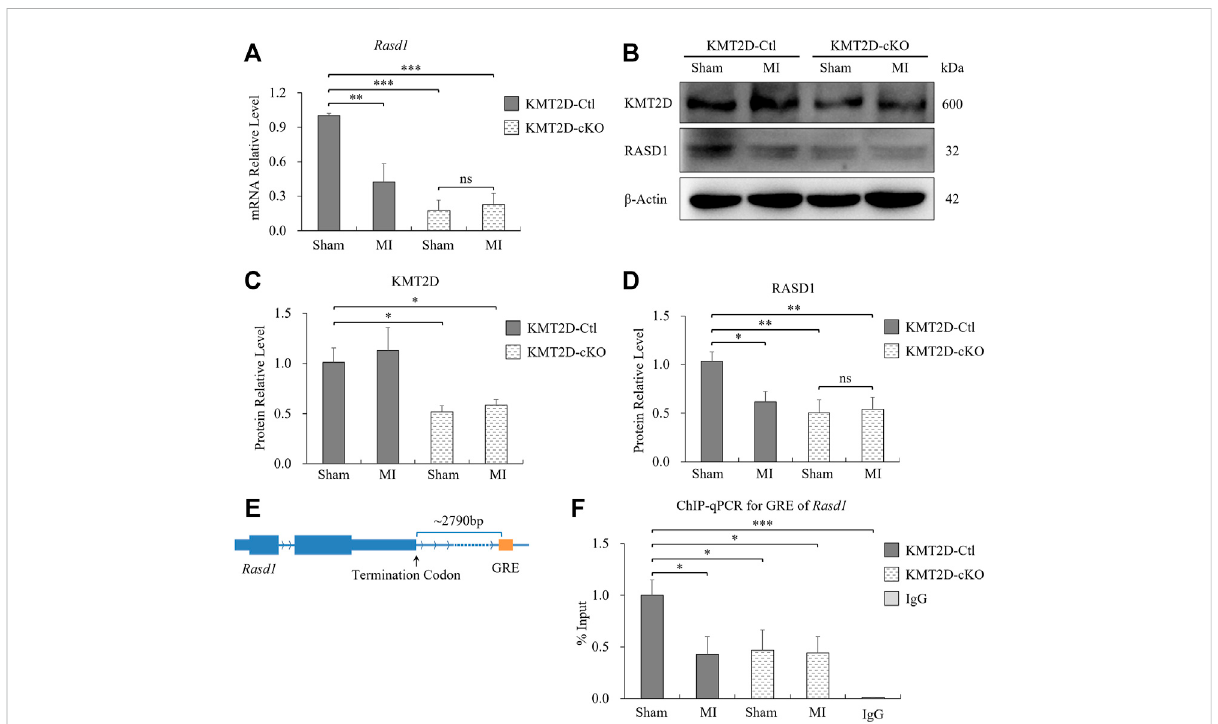
FIGURE 3 Expression of Rasd1 intheheartwassigni fi cantlyreducedbyischemiaandKMT2Ddeletioninmice. (A) qPCRmeasurementsof Rasd1 following 24 h post-MI or sham surgery in the KMT2D-Ctl and the KMT2D-cKO mice. (B) Representative images of western blots for KMT2D and RASD1, showing expression in MI/sham-operated hearts in the KMT2D-Ctl and the KMT2D-cKO mice. (C) Quantitative analysis of KMT2D expression in the KMT2D-cKO mice and the KMT2D-Ctl mice. (D) Quantitative analysis of RASD1 expression in theKMT2D-Ctl and the KMT2D-cKO mice during MI and sham groups. (E) Schematic diagram for the GRE motif of Rasd1 gene. (F) ChIP-qPCR data quantifying enrichment of H3K4me1 at the GRE of Rasd1 enhancer in all groups. ( n = 3 of each group; * p < 0.05, ** p < 0.01, *** p <